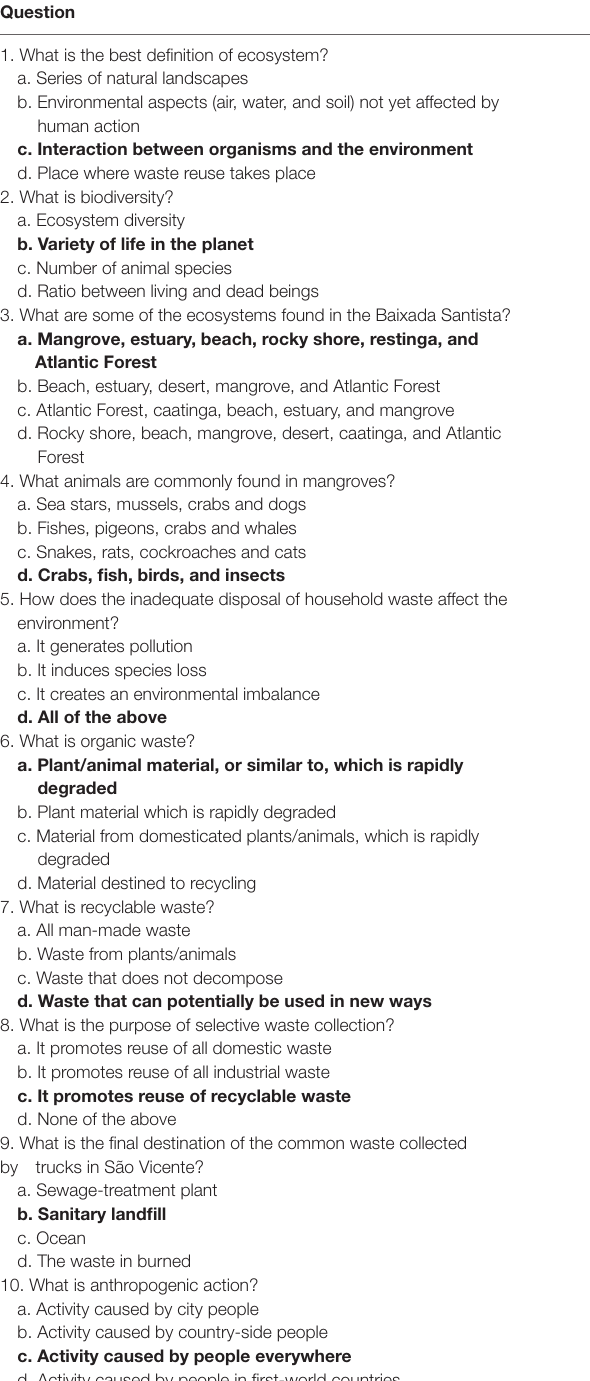
TABLE 1 | List of multiple-choice questions asked on Q1 and